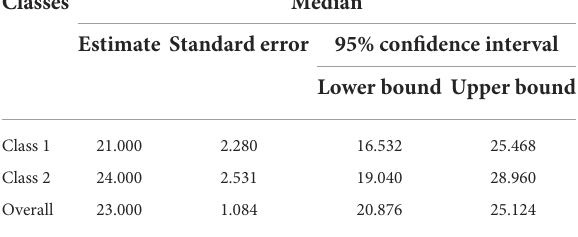
TABLE 2 Median survival times of latent classes.